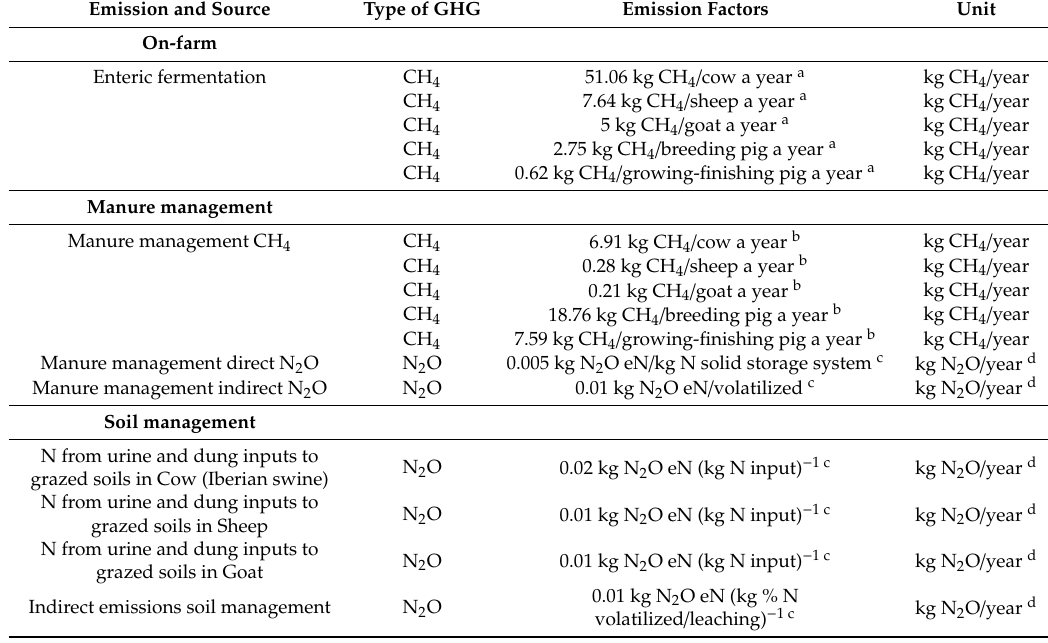
Table 2. Emission factors used to quantify greenhouse gas emissions